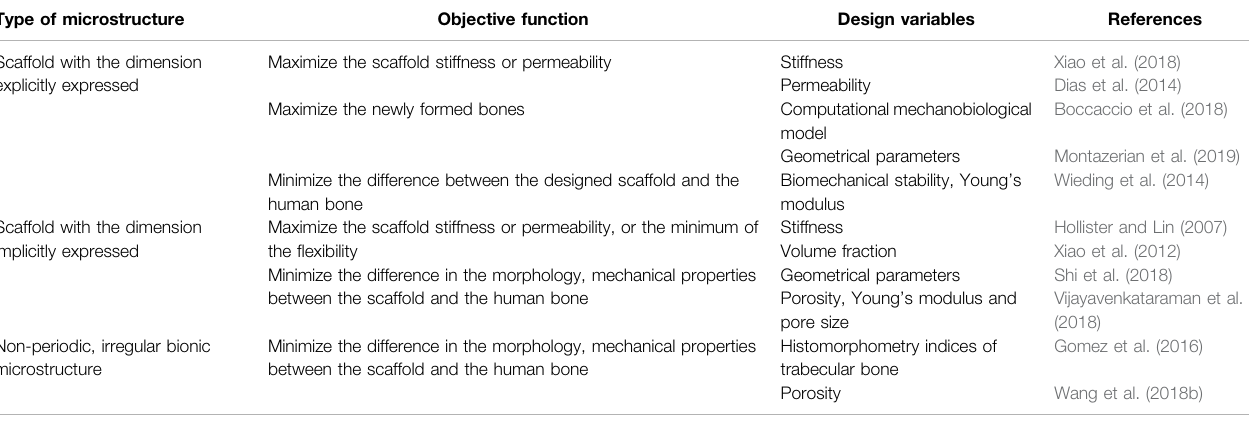
TABLE 4 | State-of-art review on the optimization of the microstructure of bone scaffolds.